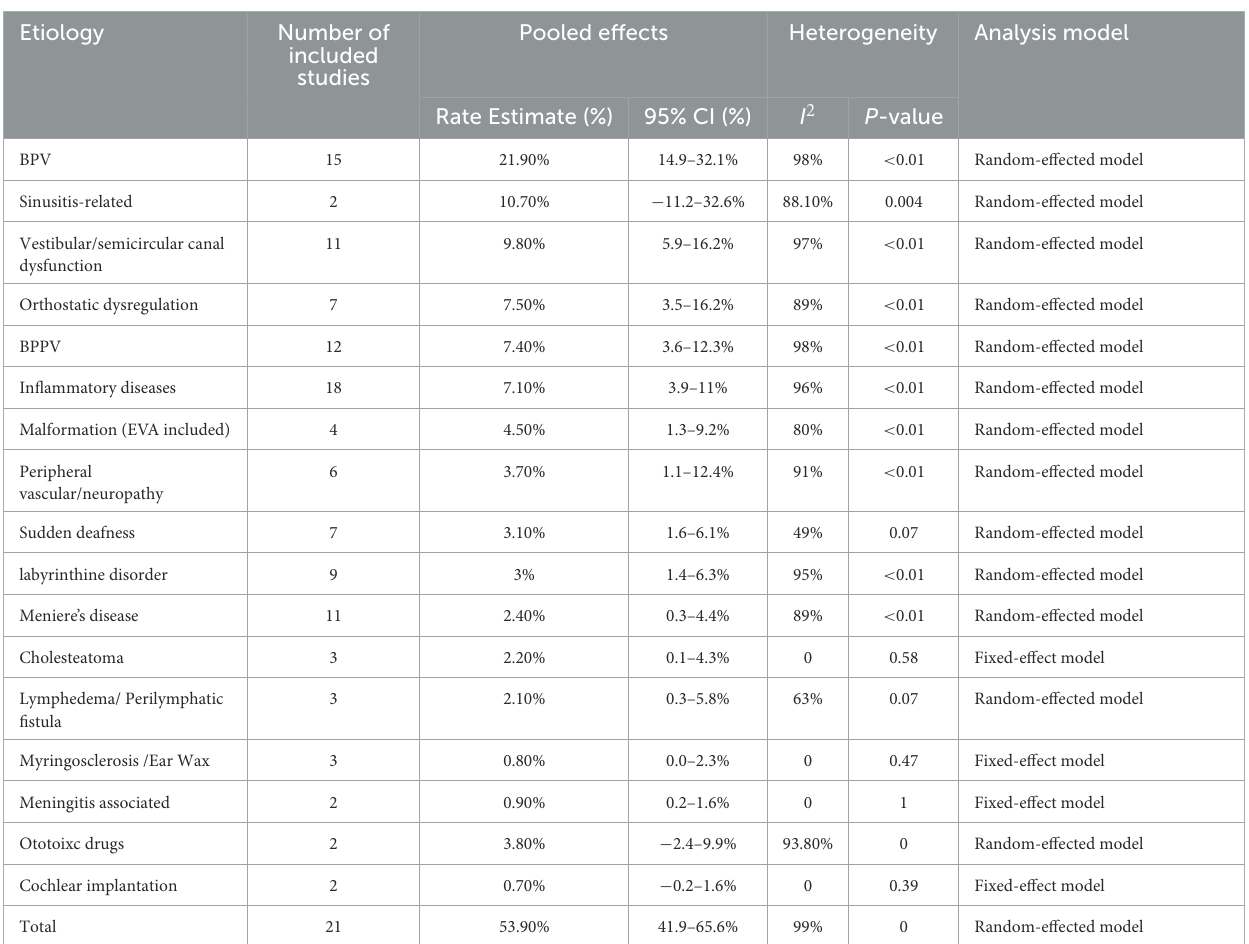
TABLE 3 Pooled analysis of each etiology for peripheral vertigo